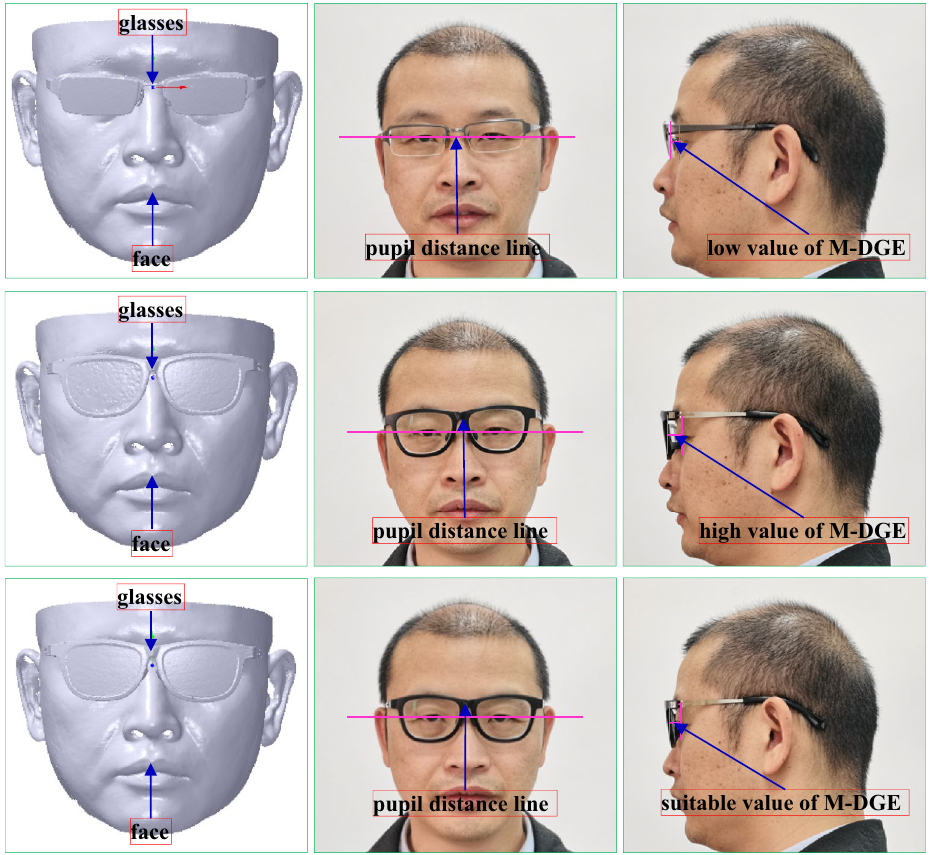
Figure 31. The try-on results of the myopic glasses of example 3. From left to right: the scanned face with glasses, the front view, the left view. From top to bottom: commercial glasses, the method of Liu 10 , our method.